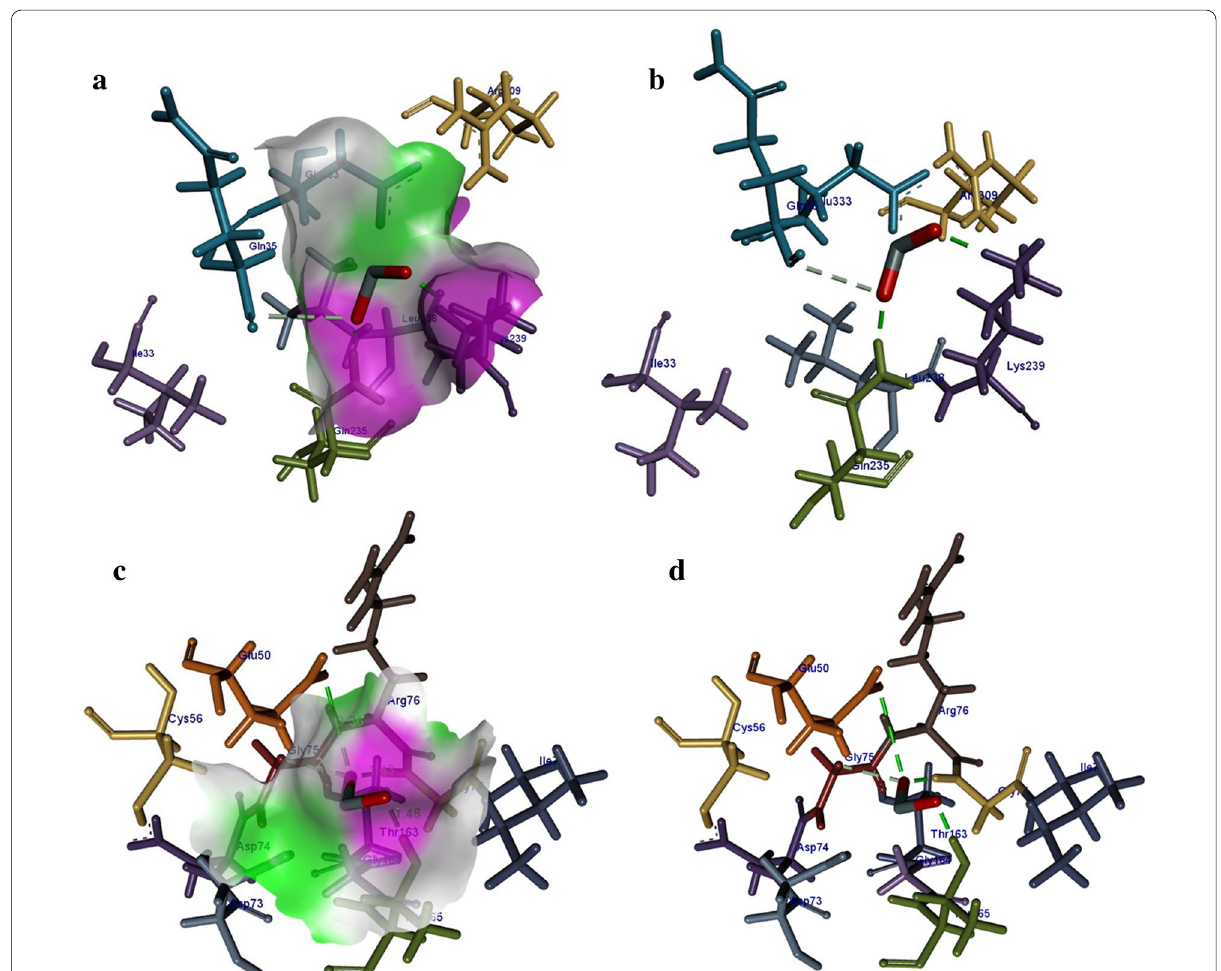
Fig. 12 a , b Binding interaction pattern of SnO 2 nanoparticle with active site residues of β ‑lactamase and c , d DNA gyrase from E.